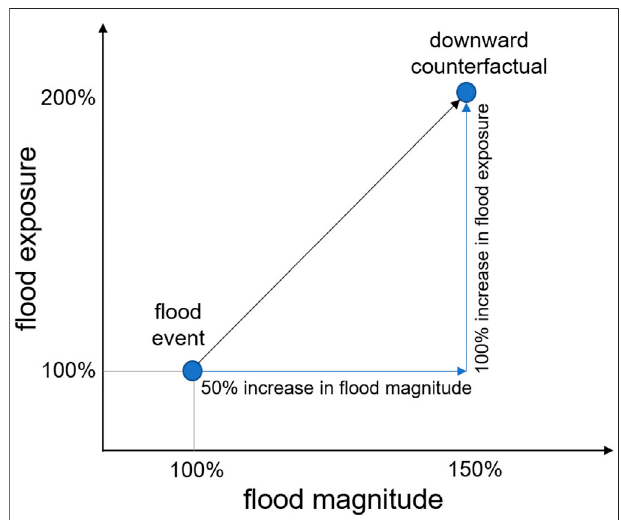
FIGURE 1 | Generalized scheme of the proposed method for mapping the sensitivity of fl oodplains to changes in fl ood magnitude in terms of exposure using downward counterfactual